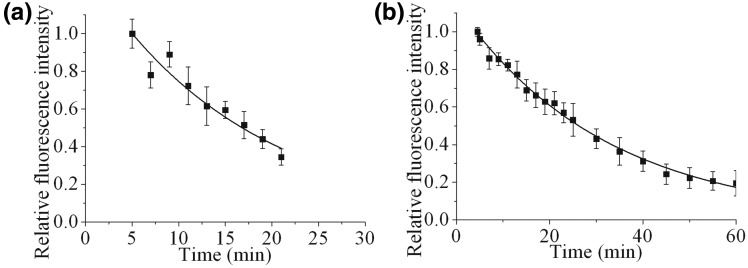
Dependence of recruitment and loss of fluorescence intensity of Ku80-EGFP on time following USX irradiation of Ku80-EGFP tagged cells at 7°C with a dose of (a) 27 Gy or (b) 137 Gy followed by incubation at 37°C. For real-time analysis, each point represents the relative fluorescence intensity normalized to the intensity at ‘zero time’ following irradiation and maintaining the cells at 37°C. The kinetic analysis to obtain the best fit to the experimental data are shown as solid lines and described in the Materials and Methods section.